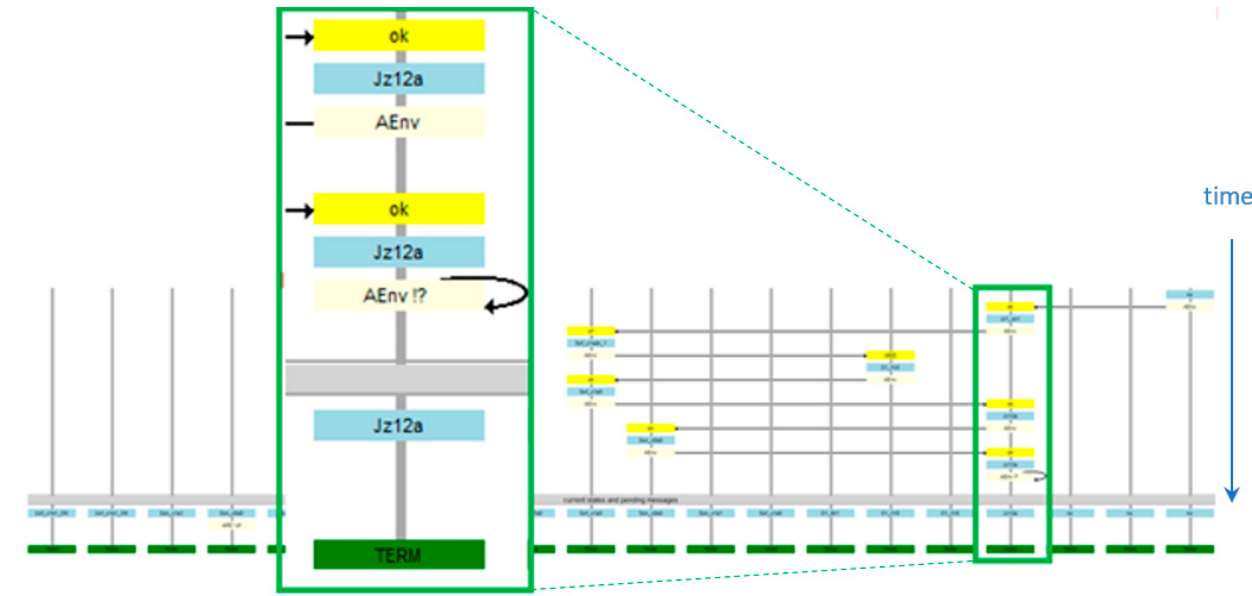
Figure 12. The witness of correct termination—the initial fragment.